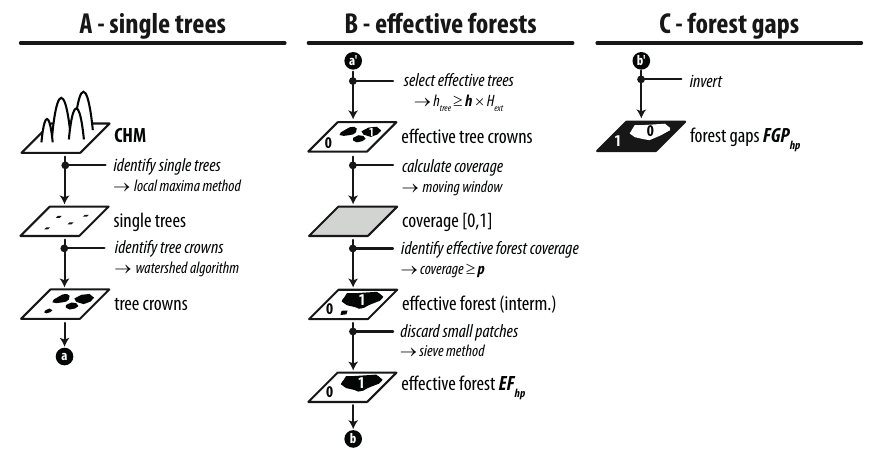
Figure 3. Workflow for the identification of forest gaps ( FGP hp ). It is based on (A) the delineation and characterization of trees based on a CHM, (B) the identification of effective forests EF hp subject to height factor h and minimum forest coverage p , and (C) the inversion of EF hp to obtain forest gaps FGP hp